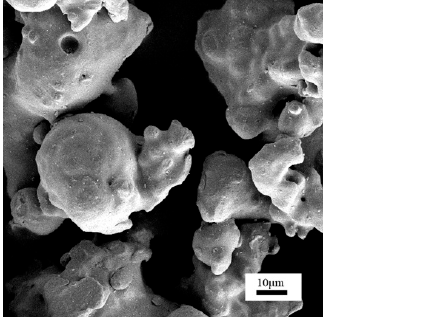
Figure 2. ( a ) SEM image of iron powders; ( b ) SEM image of coated iron powders.